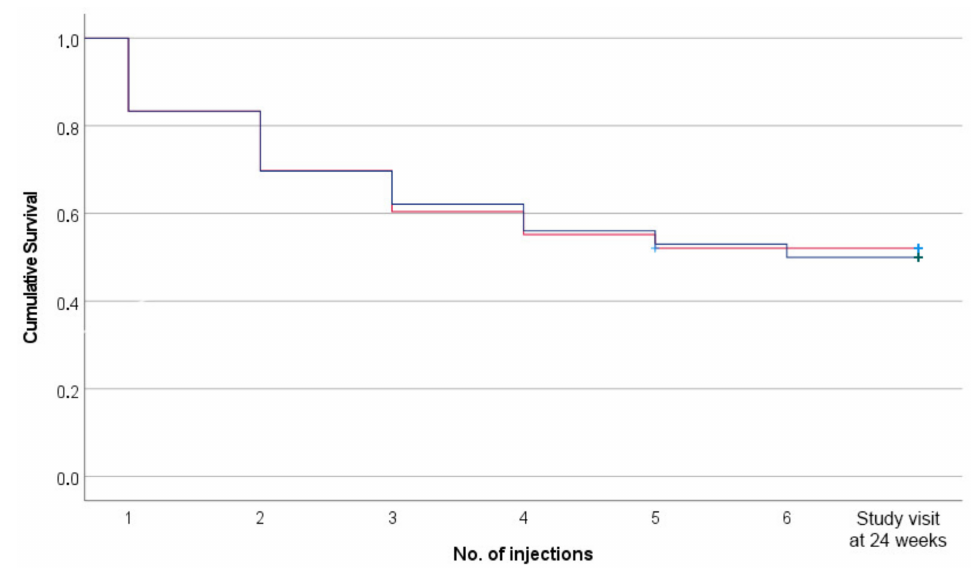
Figure 1. Kaplan–Meier curve of the discontinuation rate for XR-NTX. Red line = ASRS < 9 ( n = 96). Blue line = ASRS ≥ 9 ( n = 66). Log rank test = 0.03 ( p = 0.859). Injections were given after detox and every 4 weeks. The last marker on the x-axis represents attending the 24-weeks study visit. Table 2. Cox regression containing examined predictors for discontinuation of XR-NTX ( n = 162). Variable B HR CI p -Value ASRS > cut-off − 0.14